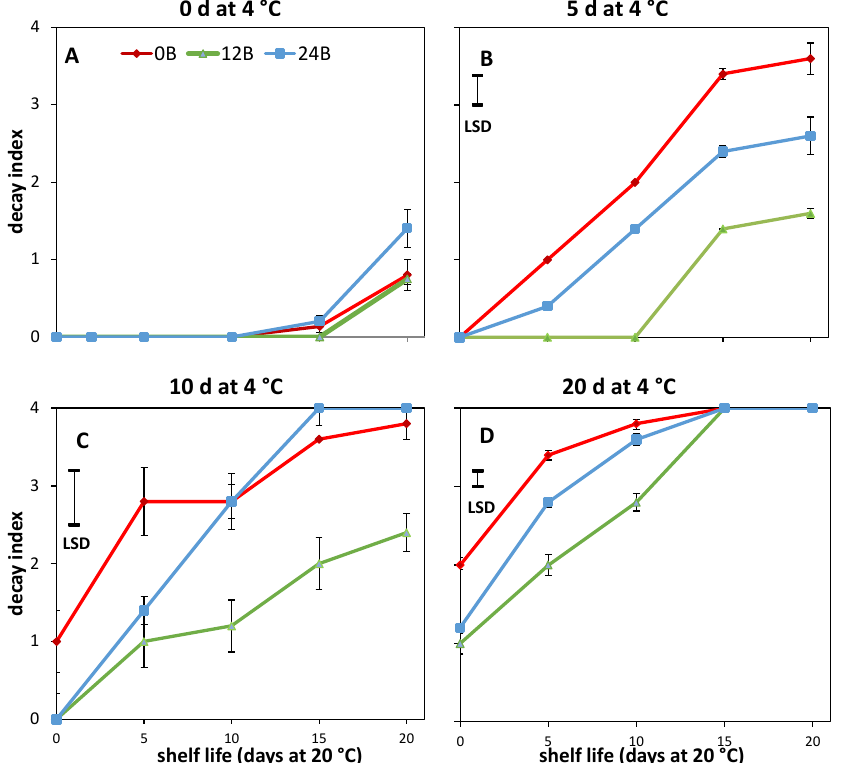
Figure 1. Average decay index with indicated standard error during shelf life (20 °C) for five red (R) tomatoes per cold storage duration. Red, green and blue symbols indicate cultivation at 0, 12 and 24% additional blue light, respectively. Tomatoes were either non-stored ( A ) or cold stored at 4 °C for 5 d ( B ), 10 d ( C ) or 20 d ( D ). LSD values, when present, are indicated per panel.